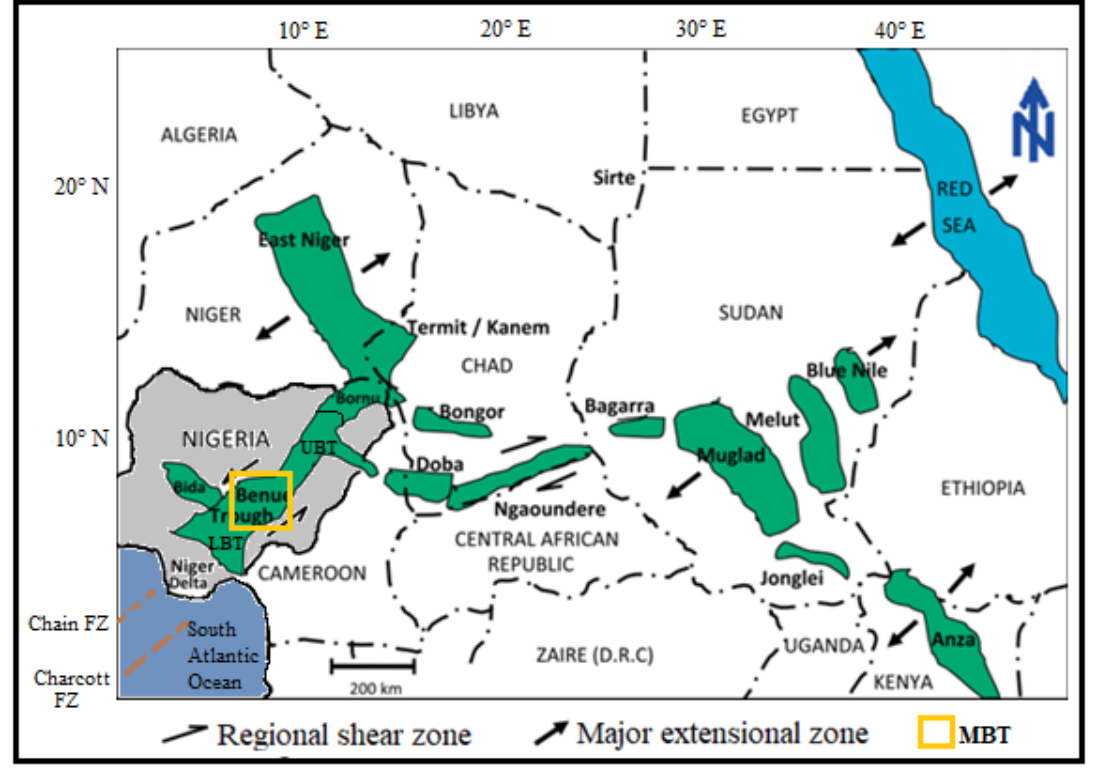
Figure 1. West and Central African Rift System regional tectonic map. FZ denotes fracture zone (modified after Schull [32] and Anudu et al. [1]).